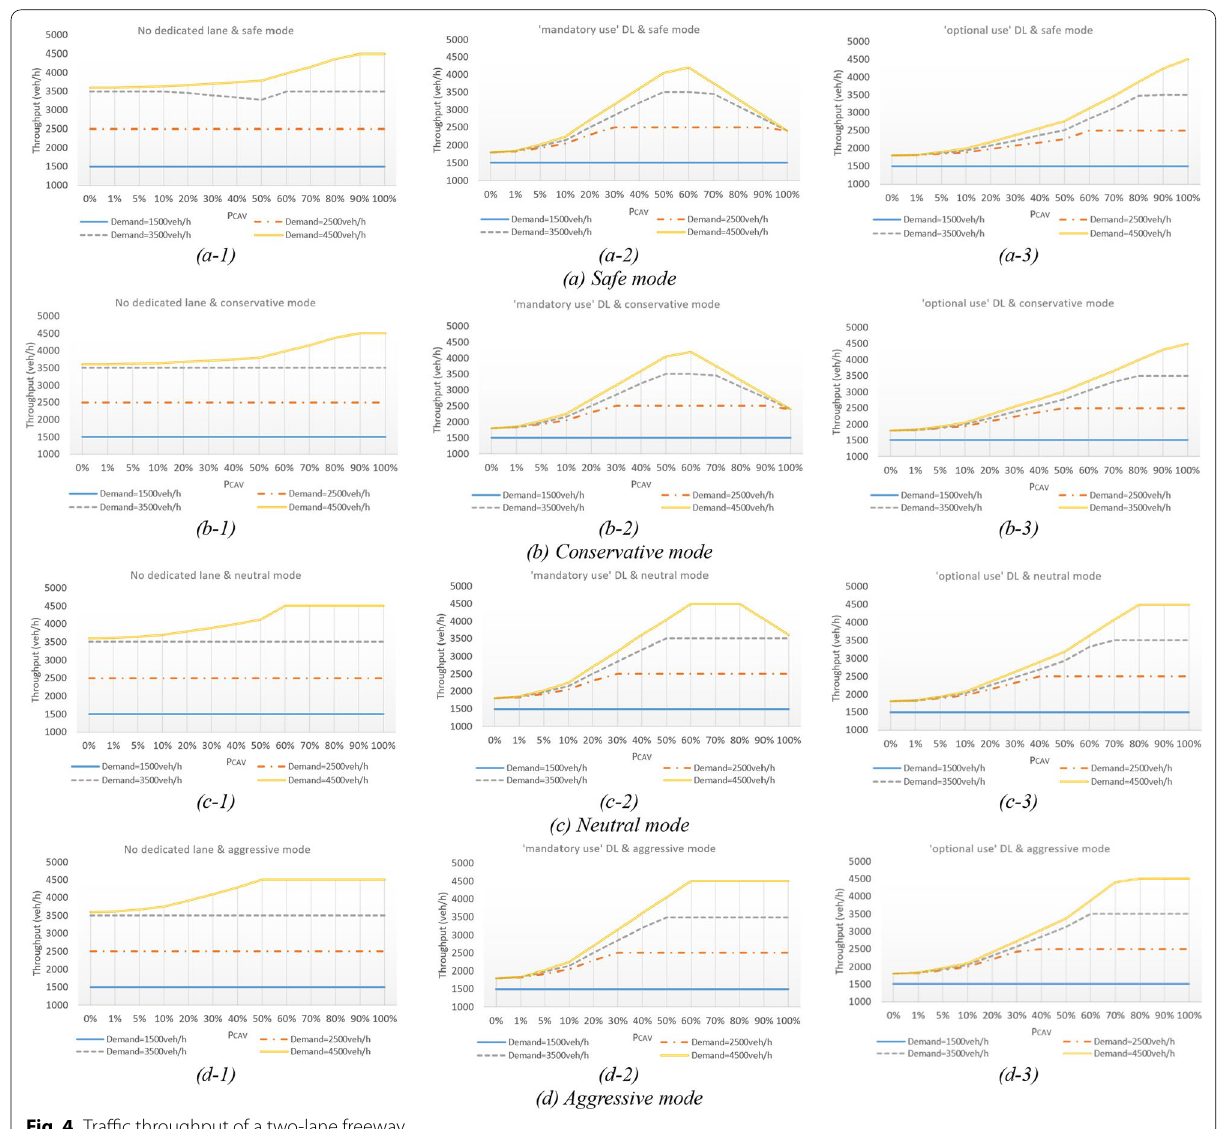
Fig. 4 Traffic throughput of a two-lane freeway